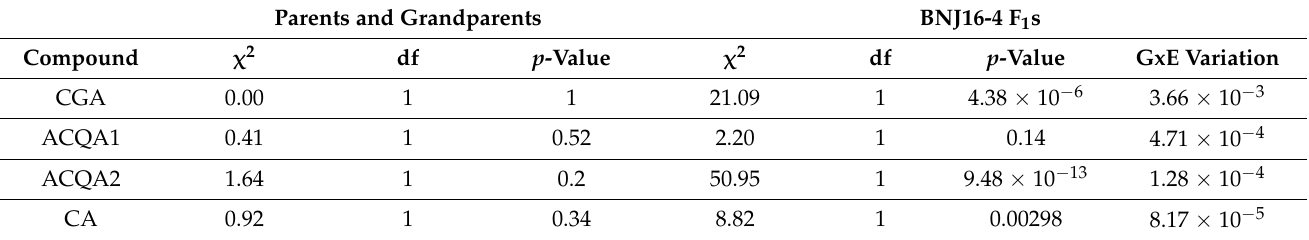
Table 3. Kruskal–Wallis rank sum test with phenolic acid concentrations (mg/g fresh weight) in blueberry fruit by harvest year (alpha = 0.05) in the parents, grandparents, and BNJ16-4 population and genotype-by-environment (GxE) variation in the BNJ16-4 population. Parents and Grandparents BNJ16-4 F 1 s